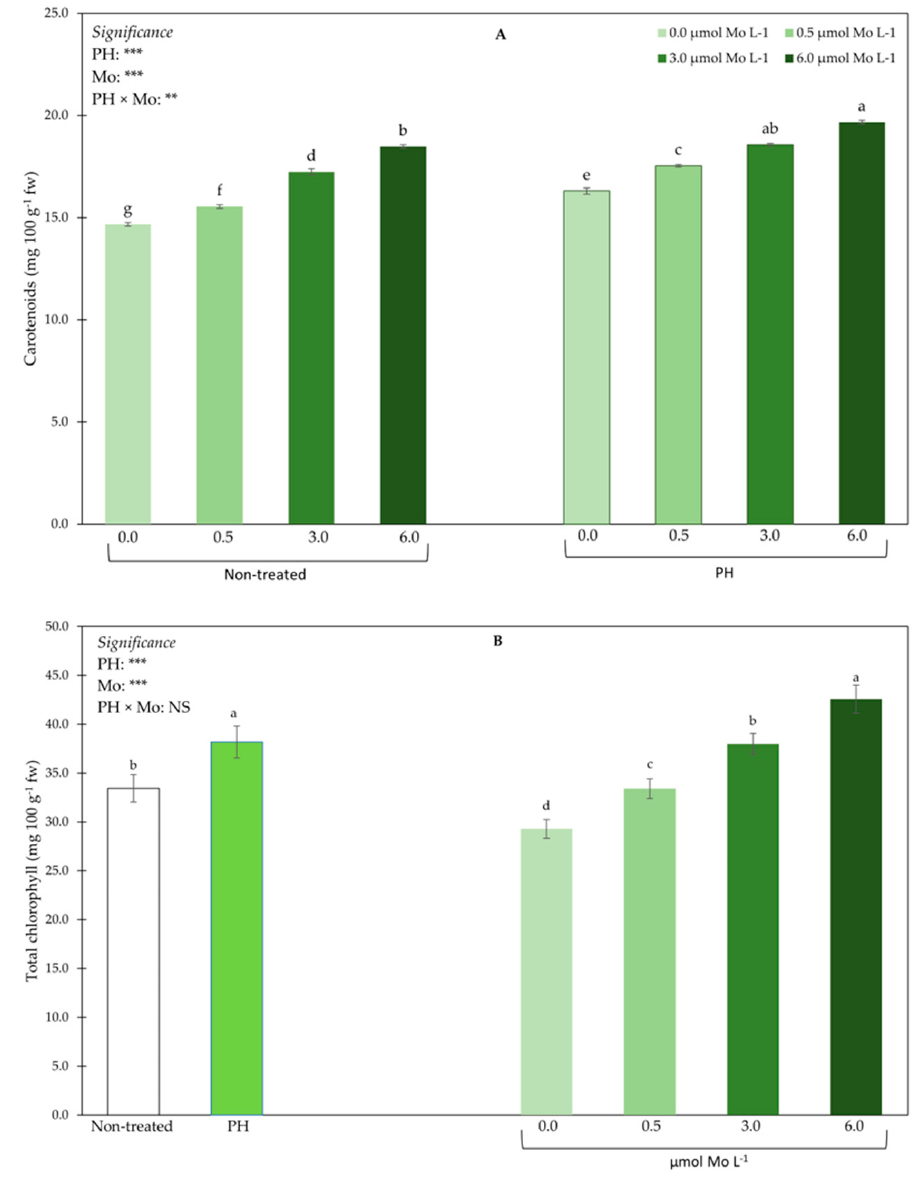
Figure 4. Effects of PHs and Mo treatments on carotenoids ( A ) and total chlorophyll ( B ) concentration in ‘Canasta’ lettuce plants. Values with distinct letters significantly differ at p ≤ 0.05. NS, **, *** non-significant or significant at 0.005 or 0.001,